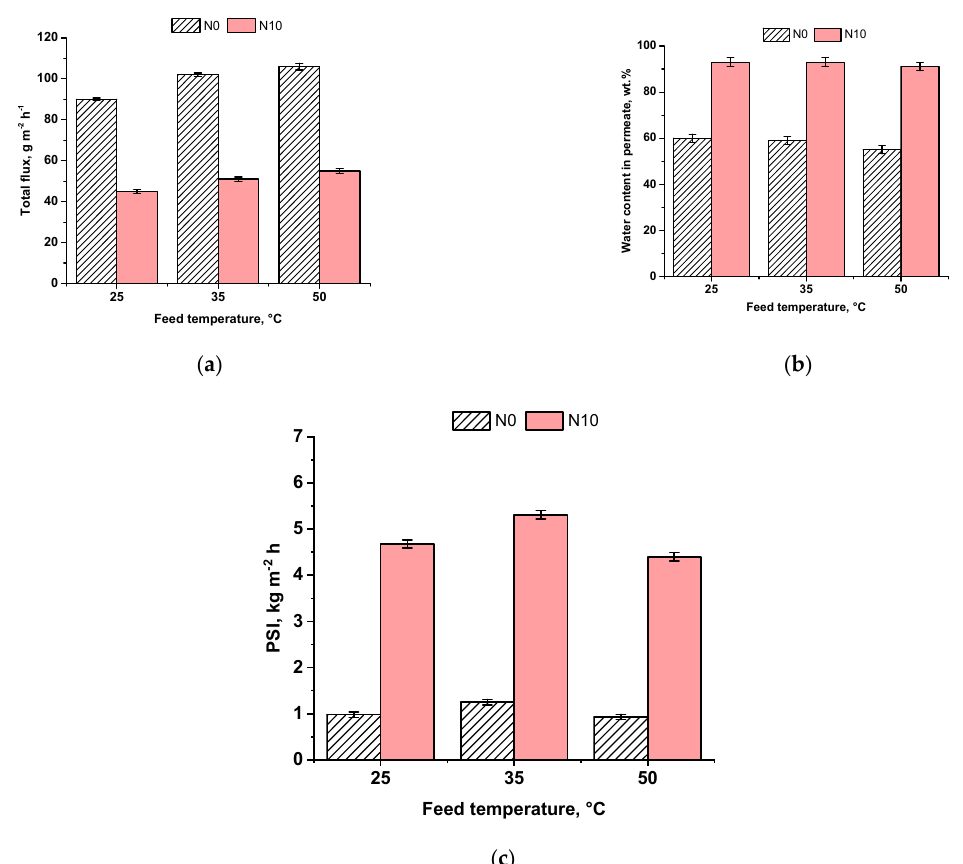
Figure 7. Total flux ( a ), water content in permeate ( b ) and PSI ( c ) of membranes versus the temperature of the feed solution in pervaporation of 90 wt.% ethanol/10 wt.% water mixture.